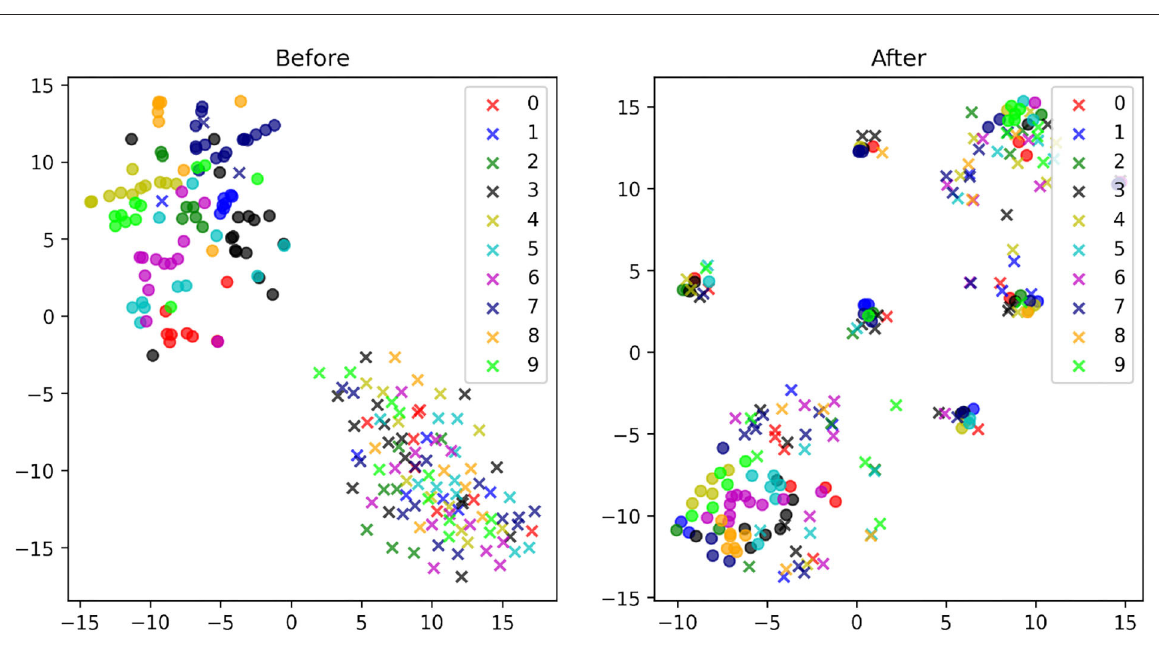
FIGURE9 The t-SNE plots of the MNIST (circles) and MNIST-M (crosses) images with the corresponding digits they represent given in a unique color before (left) and after (right) the proposed